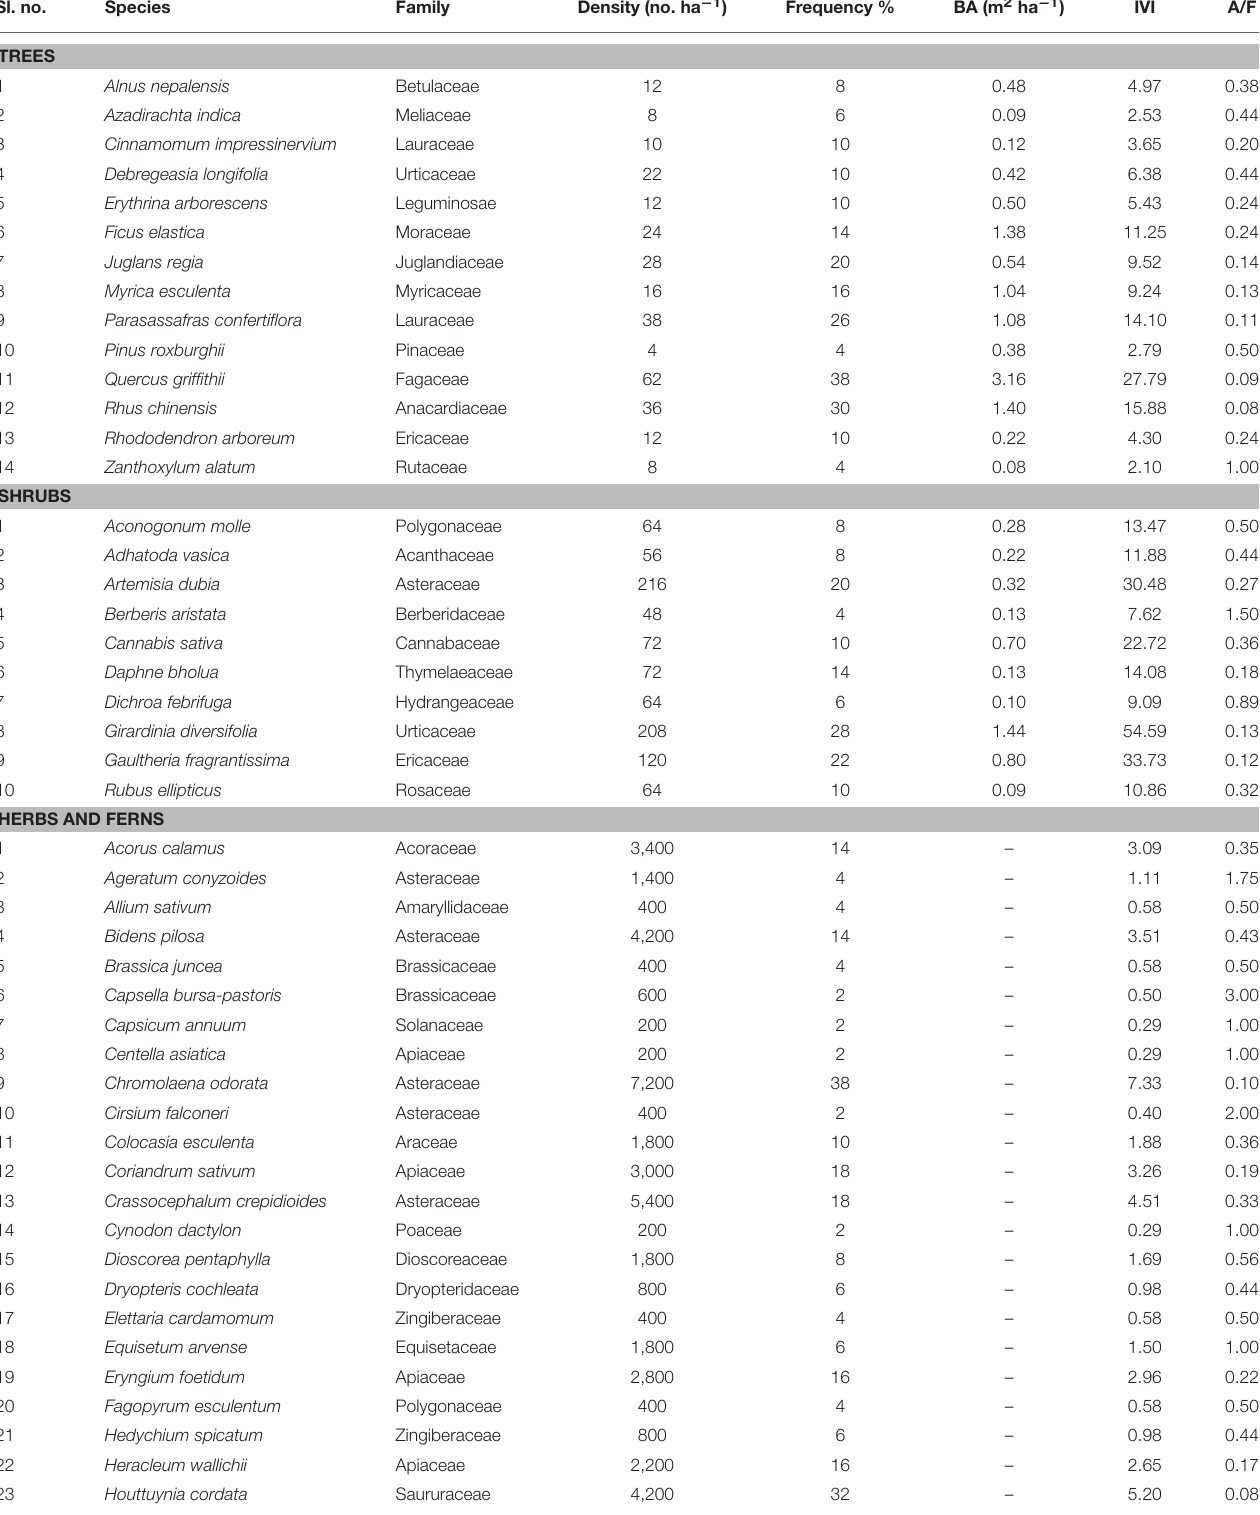
TABLE 1 | Density, basal area, percentage frequency, A/F ratio and important value index of medicinal plant species in the broad-leaf mixed coniferous forests of Tshothang Chiwog, Bhutan. Sl.